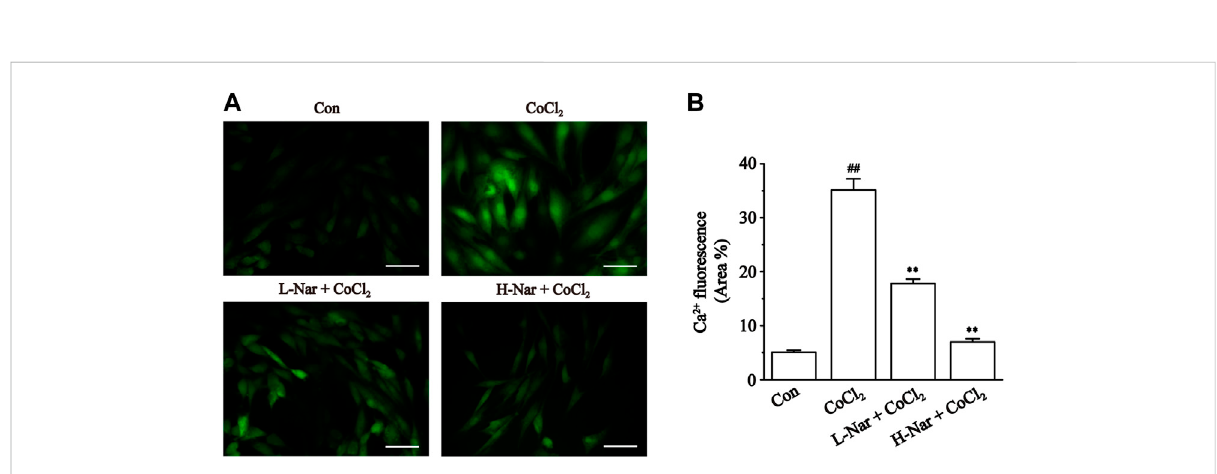
FIGURE 8 Effects of Nar on CoCl 2 -induced the levels of Ca 2+ concentration in H9c2. (A) Morphological changes of intracellular Ca 2+ as observed by Fluo-3 staining (scale bar:50 μ m;magni fi cation: ×400). (B) Statistical analysis of ROS fl uorescence was presented. Data were expressed as the mean ± SEM of each group. ## p < 0.01 vs. Con group; * p < 0.05, ** p < 0.01 vs. CoCl 2 group, n = 6 each group. Note: L-Nar: 10 μ M and H-Nar: 30 μ